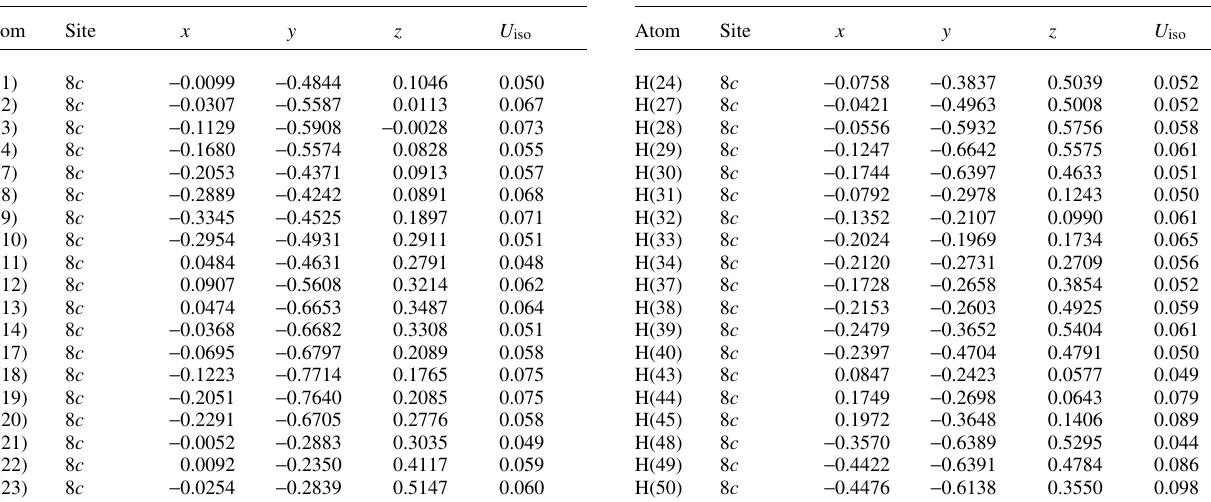
Table 2. Atomic coordinates and displacement parameters (in Å 2 )